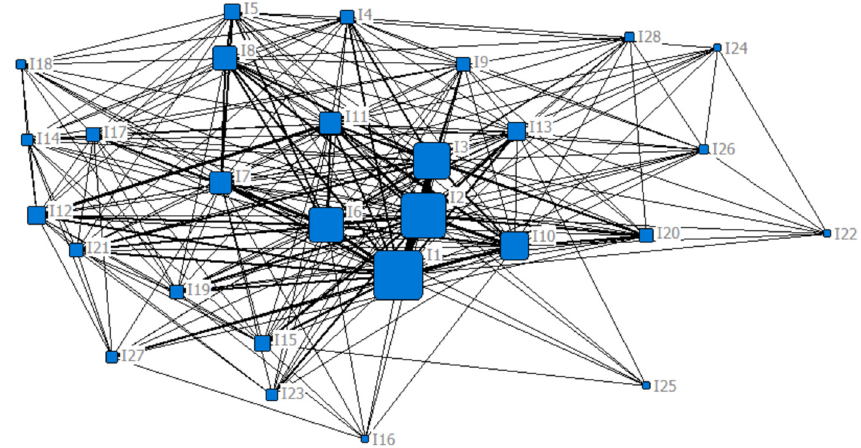
Figure 3. The social network of the influencing factors of Chinese urban community function loss under the flood disaster with the added degree centrality attribute.